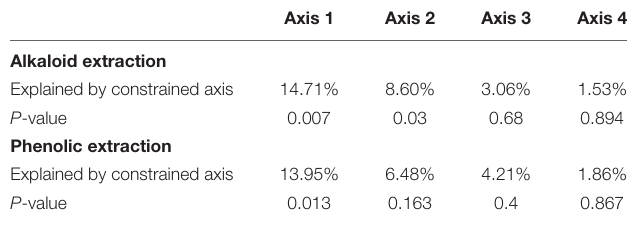
TABLE 4 | Significance of constrained axes of CCA diagrams.